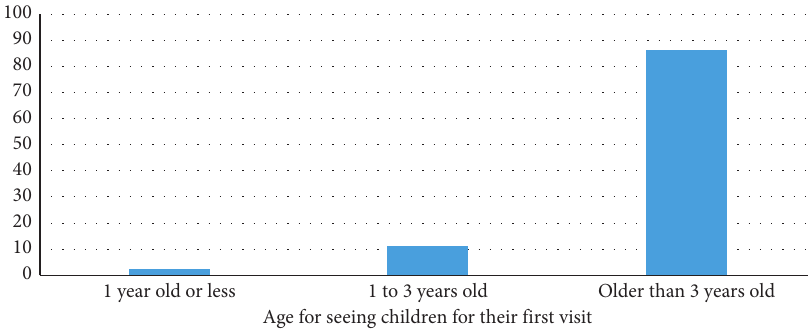
Figure 2: Distribution of age for children’s first dental visit ( N � 335). Table 1: Distribution of dentists’ practices of AG.